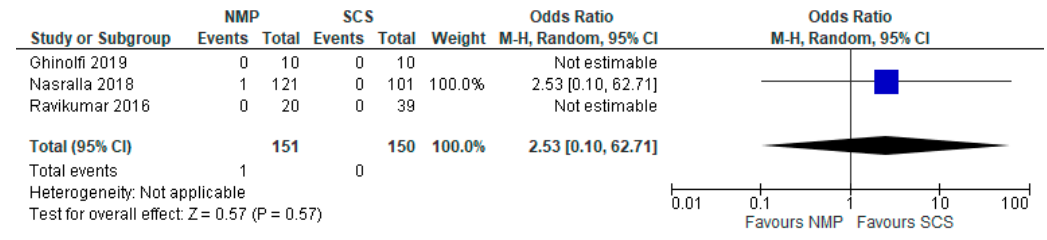
Figure 11. Primary nonfunction in livers preserved via HMP and SCS.